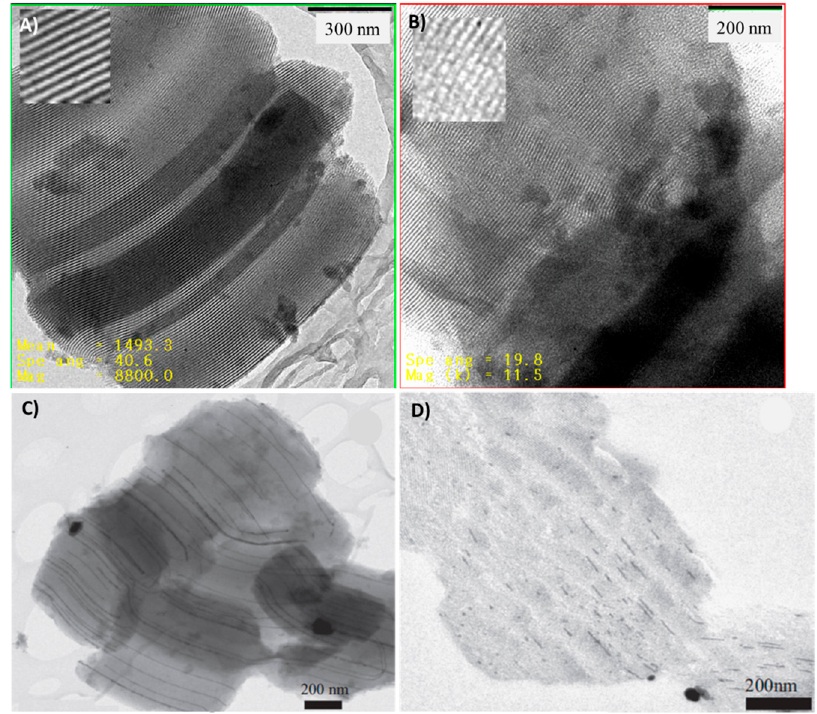
Figure 7. Bright field TEM images of ( A ) open SBA-15 and ( B ) plugged SBA-15 [13] and HRTEM images of silver nanowire in ( C ) conventional SBA-15 ( D ) plugged SBA-15